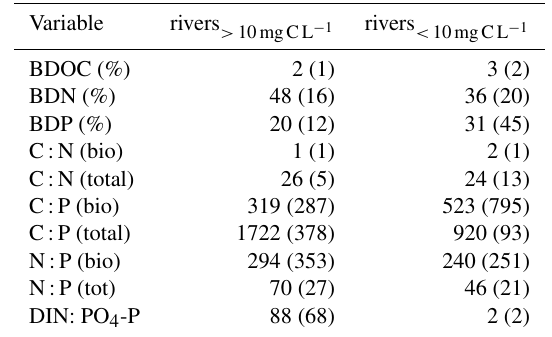
these and DIN : PO 4 -P ratios for both rivers pendent t test, p > 0.07, n = 4) and rivers dent t test, p > 0.10, n =